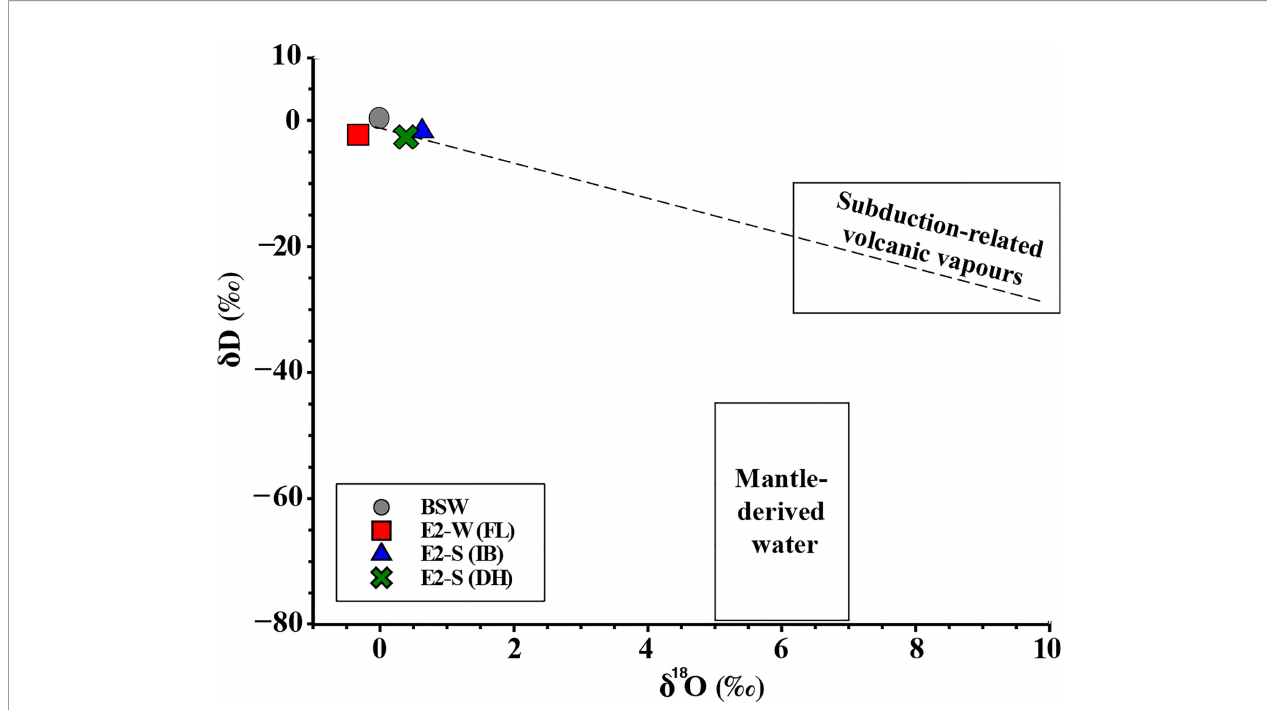
FIGURE 9 | Endmember water isotopic composition for E2-S and measured values for E2-W fl uids. The dashed line is the least square regression line for the E2-S fl uids and BSW. Data for subduction related volcanic vapours and mantle derived water were taken from Taylor, (1979; Ohmoto (1986) and Giggenbach (1992); Hedenquist and Lowenstern (1994),